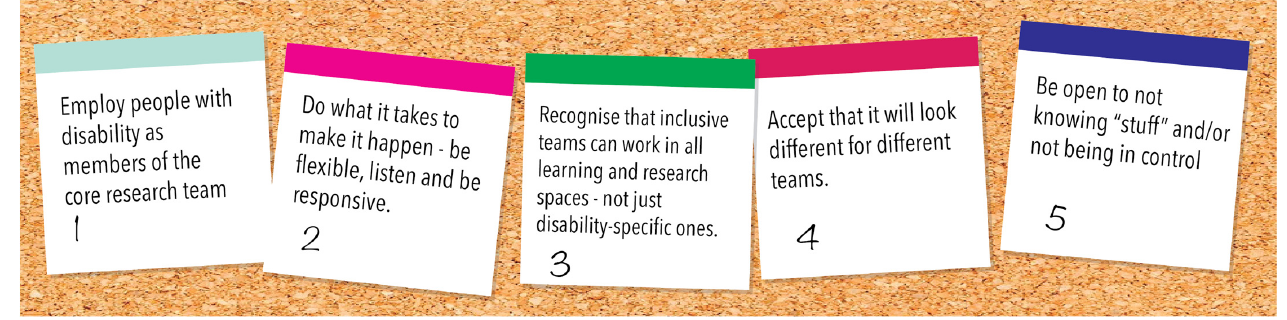
Figure 1. Our team came up with five tips to guide the development of more inclusive research teams within university settings. These are all based on what we learnt collaboratively during the research project.